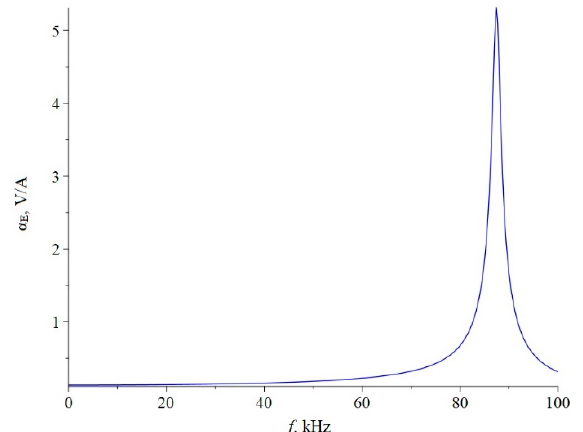
Figure 18. Theoretical dependence of the ME voltage coefficient on the frequency of the alternating magnetic field for ME structure Metglas/LiNbO 3 Zyl + 45° in case of torsional mode.